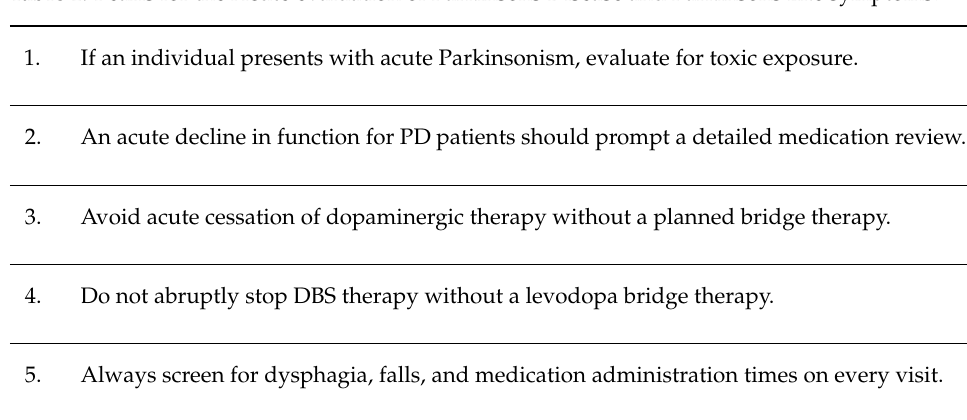
Table 1. Pearls for the Acute evaluation of Parkinsons Disease and Parkinsons like